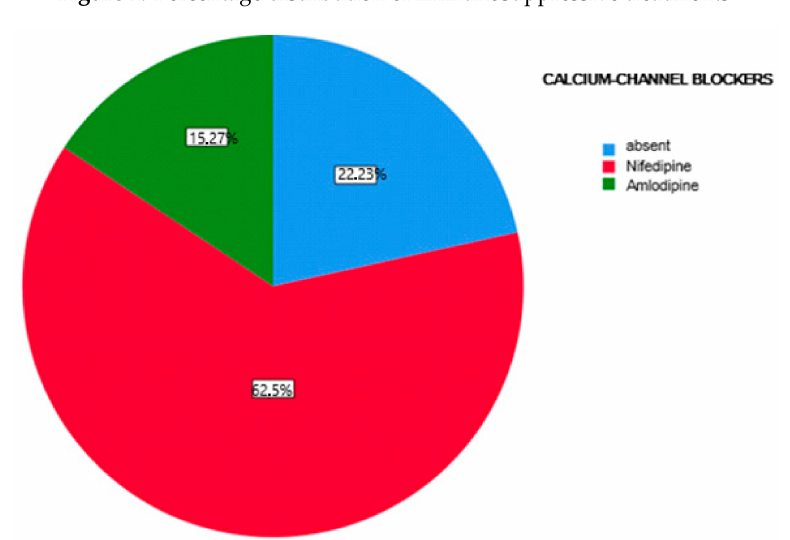
Figure 2. Percentage distribution of additional treatment with calcium channel blockers.